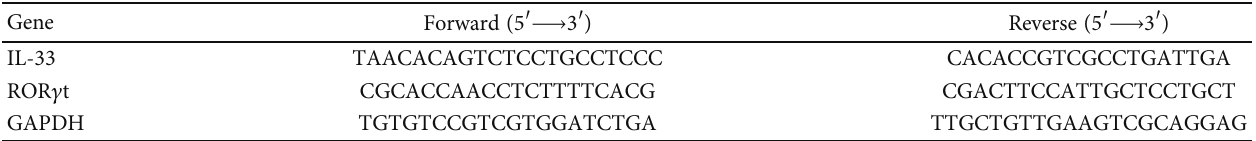
Table 1: Primer sequences of target mRNAs.